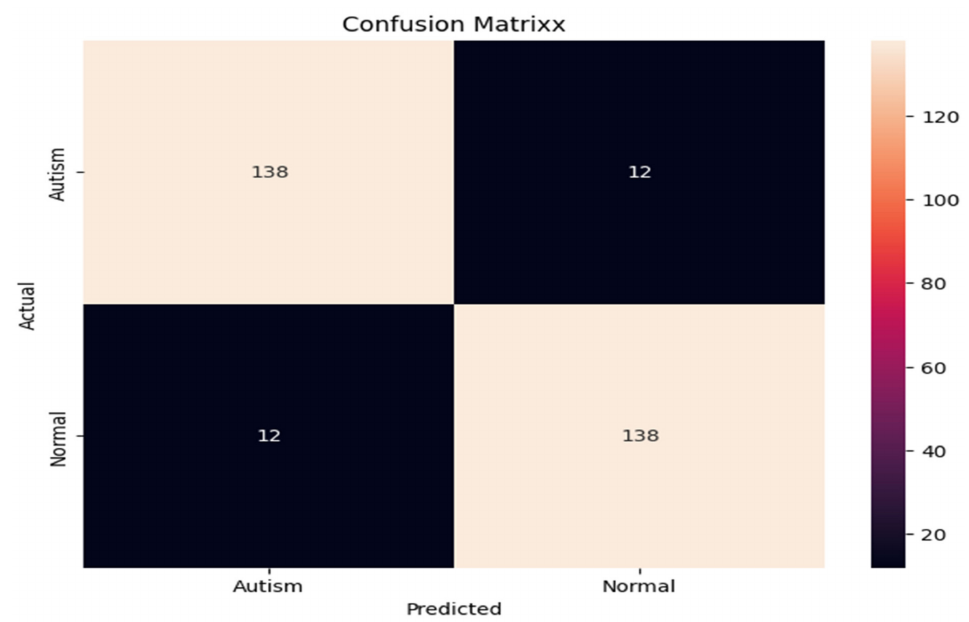
Figure 9. MobileNet model confusion